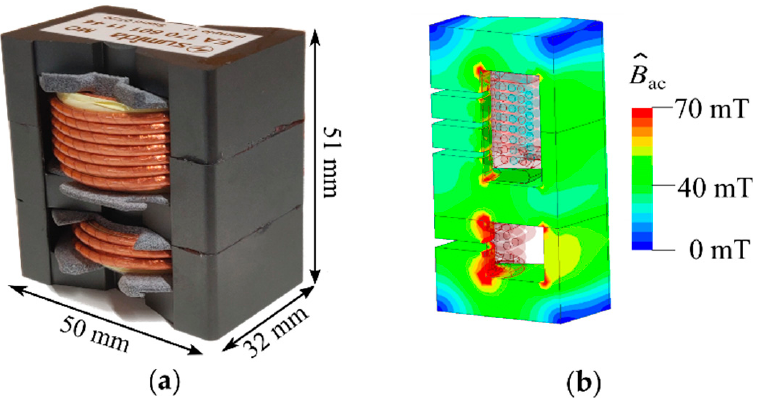
Figure 20. Image of ( a ) the built transformer and resonance inductance and ( b ) the simulated magnetic flux density. Table 8. Simulated and measured losses of the hf transformer and resonance inductor. Loss